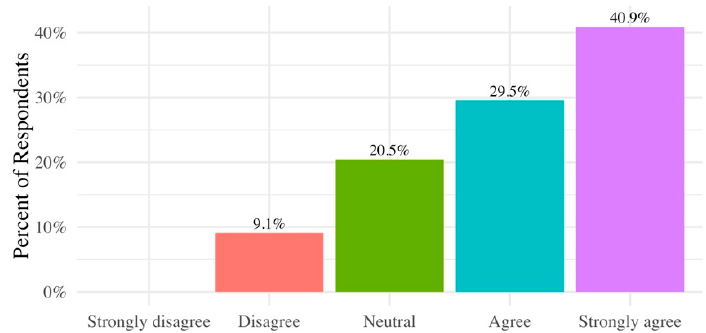
Figure A4. Participants’ perceived risk of heavy metal soil contaminants on health. Total question respondents: 44.